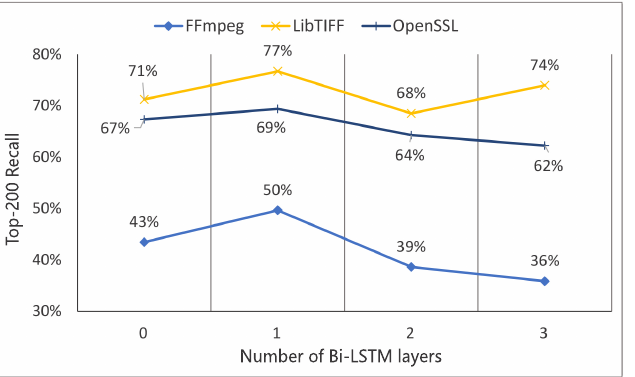
Figure 5. The top-200 recall of our framework with different number of Bi-LSTM layers on projects: FFmpeg, LibTIFF and